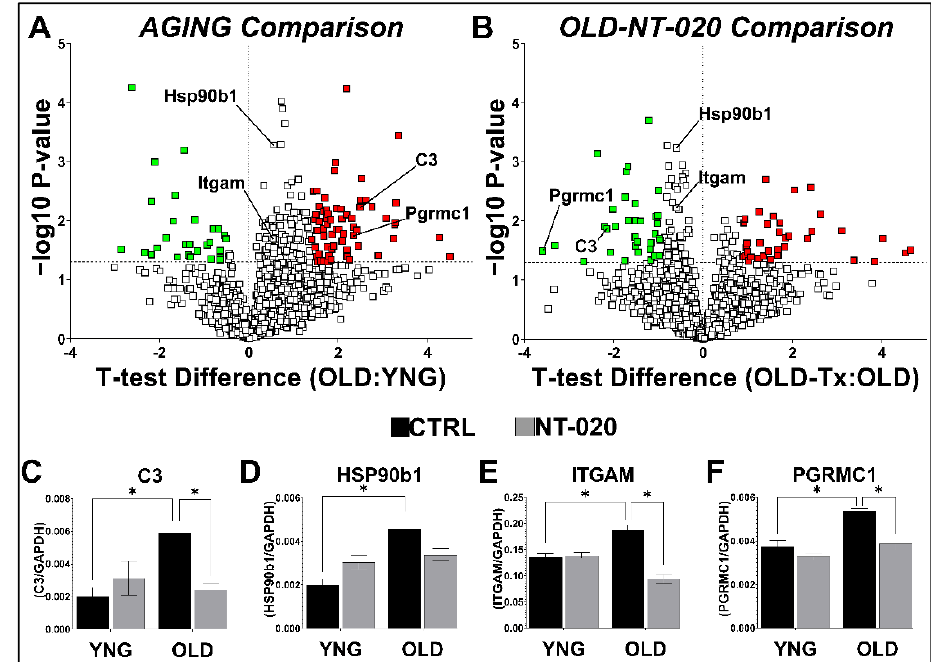
Figure 1. Differential microglial protein expression in AGING and NT-020 comparisons. Protein fold change was calculated using average LFQ intensities among samples ( n = 4 rats per group) across three comparisons: AGING ( OLD ), YNG-NT-020 ( YNG − Tx ), and OLD-NT-020 ( OLD − Tx ). Welch’s T -test difference values were plotted against the corresponding -log 10 ( p -value) for each protein to generate volcano plots; the horizontal dotted line indicates the cutoff for statistical significance via Welch’s t -test ( p < 0.05); green (downregulated) and red (upregulated) color indicate proteins with z-score > 1 ( A , B ). Protein expression for inflammatory mediators such as ITGAM , C3 , HSP90B1 , and PGRMC1 followed the trend of being upregulated with age and downregulated with age and the NT-020 diet. MS results were validated using the Wes instrument ( C – F ). The average chemiluminescence ± SEM was obtained for 1° antibodies against ITGAM , C3 , HSP90B1 , and PGRMC1 (normalized to GAPDH ) across treatment groups ( n = 5 rats per group) and two-way ANOVA analysis was performed with Tukey’s post-hoc test (*, p < 0.05).